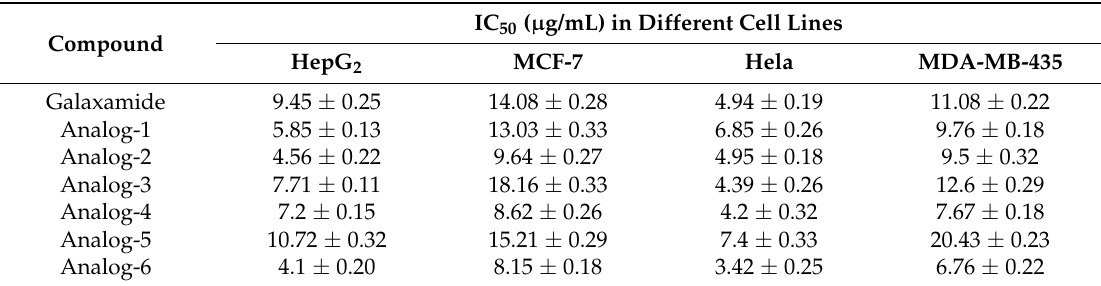
Table 1. Cytotoxicity of Galaxamide and its analogs on different human cancer cell lines.